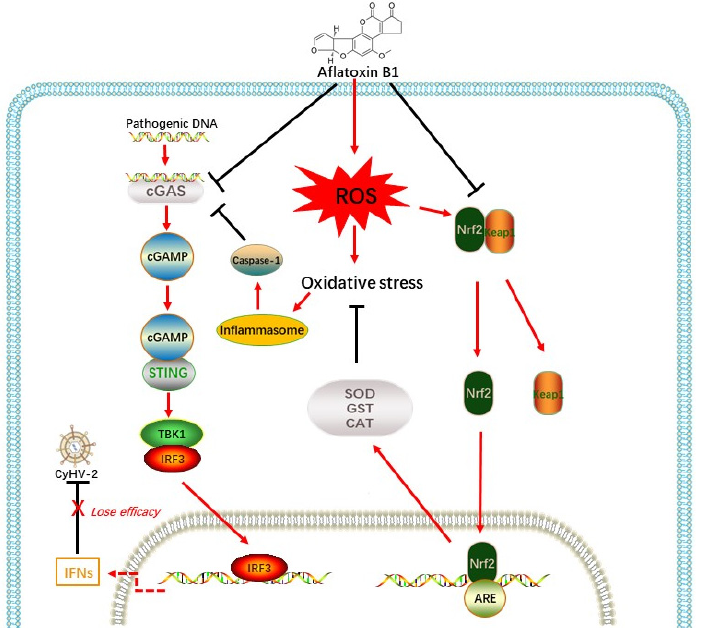
Figure 9. Proposed model for AFB1 inducing the oxidative stress and promoting CyHV-2 proliferation through suppressing the IFNs response [19,20,66].